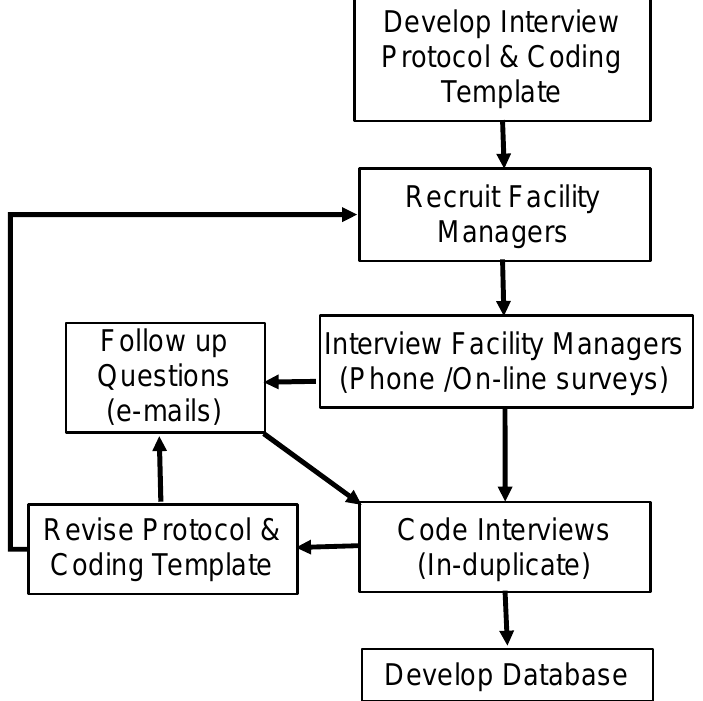
Figure 1. Schematic of workflow for building water management practitioner phone interviews and online surveys.